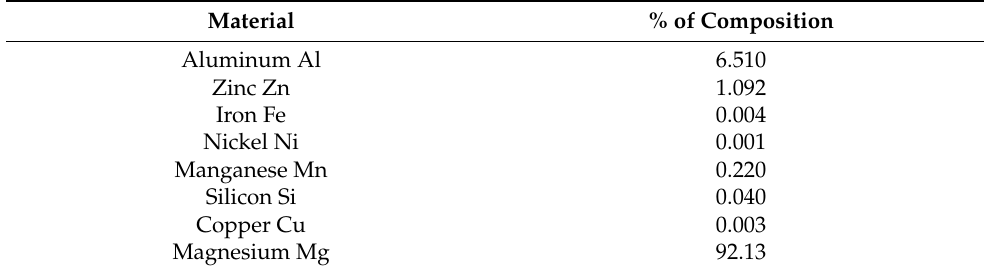
Table 1. Chemical composition of AZ61 magnesium